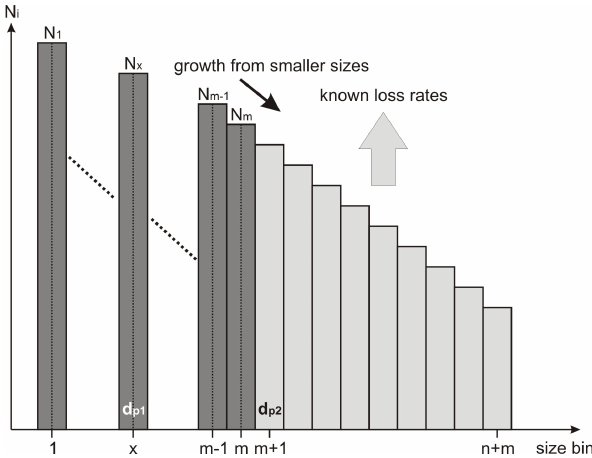
Figure 2. The original size distribution above the cutoff size d p 2 (size bin m + 1) is shown in light grey. The loss rate of particles and the rate of change of the particle concentration in this size range must be compensated for by the formation rate due to smaller parti- cles growing into the measured size range. This knowledge can be incrementally extended to bins at smaller sizes in a stepwise pro- cess, finally reaching the smaller size, d p 1 (size bin x